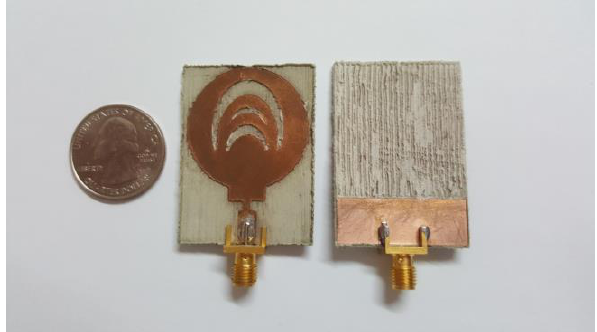
Figure 6. Fabricated circular microstrip antenna with elliptical rings.